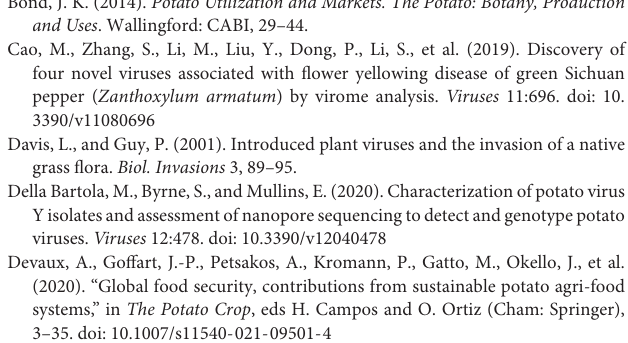
Supplementary Figure 1 | Confirmation of 3 identified viruses infecting potato by RT-PCR. Agarose gel electrophoresis results of (A) PVY, (B) PVM, and (C) PVS by RT-PCR with virus-specific primer pairs. Noted: the tubers of “Pioneer”, stolons and roots of “Talovskij” were failed in sampling and further RNA extraction and RT-PCR. Supplementary Figure 2 | A schematic diagram of the recombinant structures in the combined (A) PVM, (B) PVY, and (C) PVS datasets. Regions of recombination are marked by colored bar, and fragments originating from different parents are colored